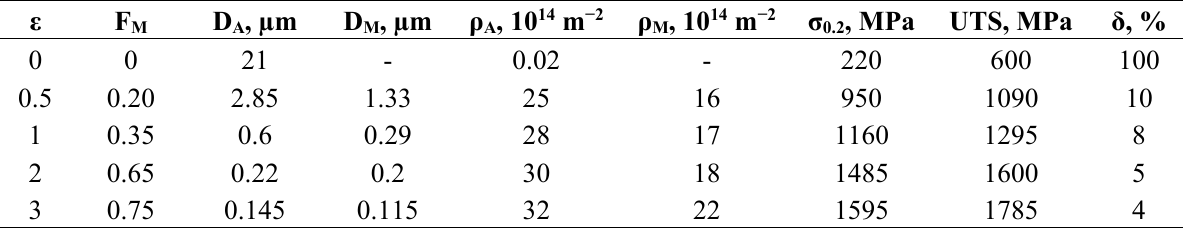
Table 1. The strain-induced martensite fraction (F M ), the grain size (D), the dislocation density (ρ), the yield strength (σ 0.2 ), the ultimate tensile strength (UTS), and the total elongation (  ) of a 304L stainless steel subjected to cold rolling to different strains (ε). The indexes of A and M indicate the austenite and martensite, respectively.